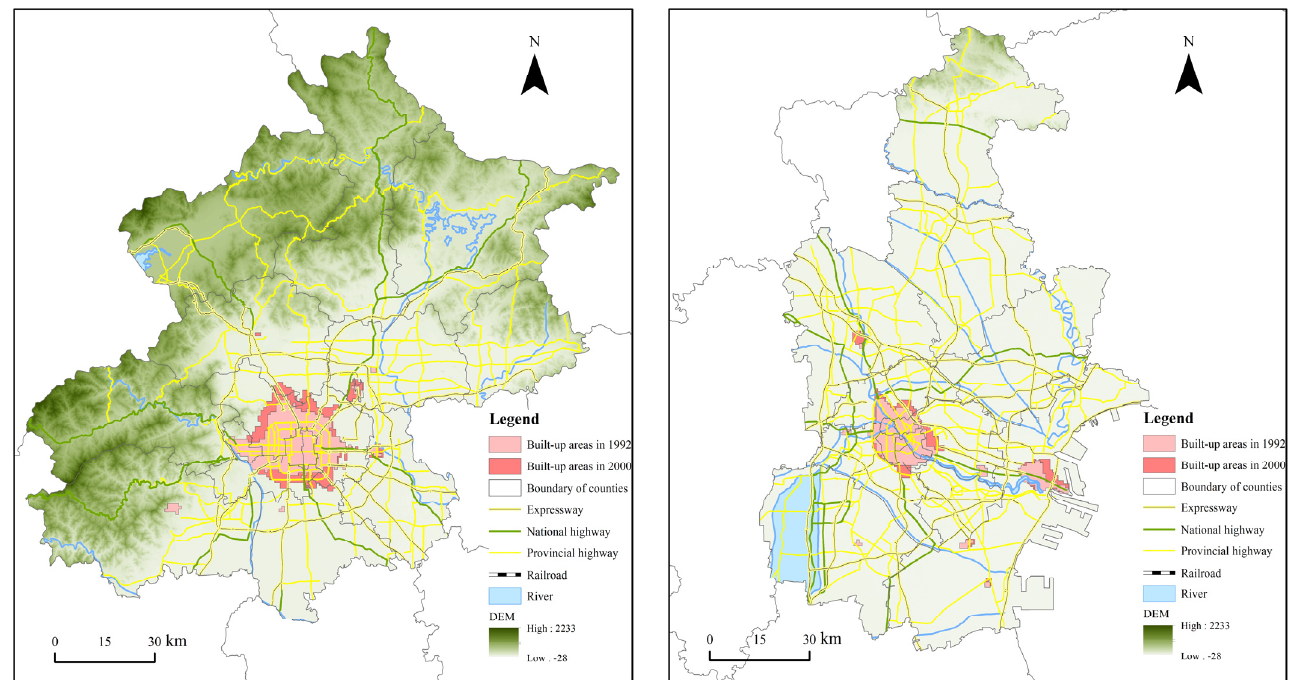
Figure 3. Spatial Expansion Patterns of Beijing and Tianjin from 1992 to 2000.